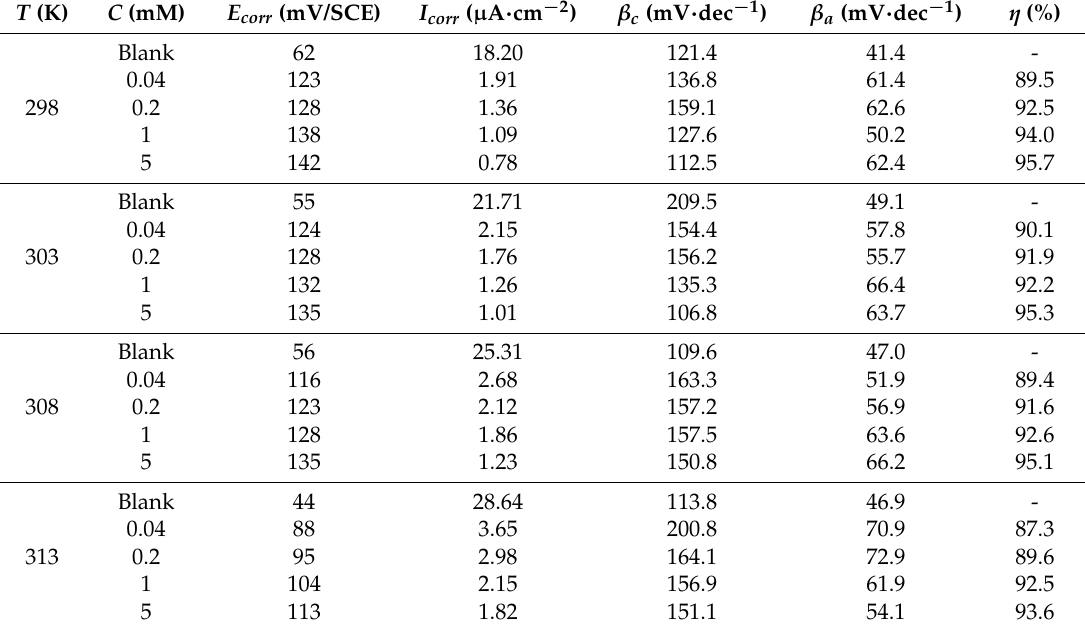
Table 1. Polarization parameters of itraconazole molecule at different temperatures in copper in 0.5 M H 2 SO 4